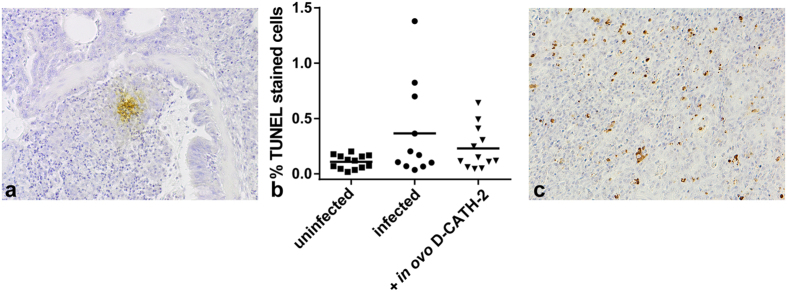
Histological parameters of lungs at 2 days post E. coli challenge. (a) Representative example of immunohistochemical staining of E. coli in lung of an infected animal (200×). (b) Percentage of apoptotic cells in lungs as determined by TUNEL assay. Data were analyzed by one-way ANOVA using a Tukey post-hoc test. (c) Representative example of TUNEL stain in lung of an infected animal (400×).